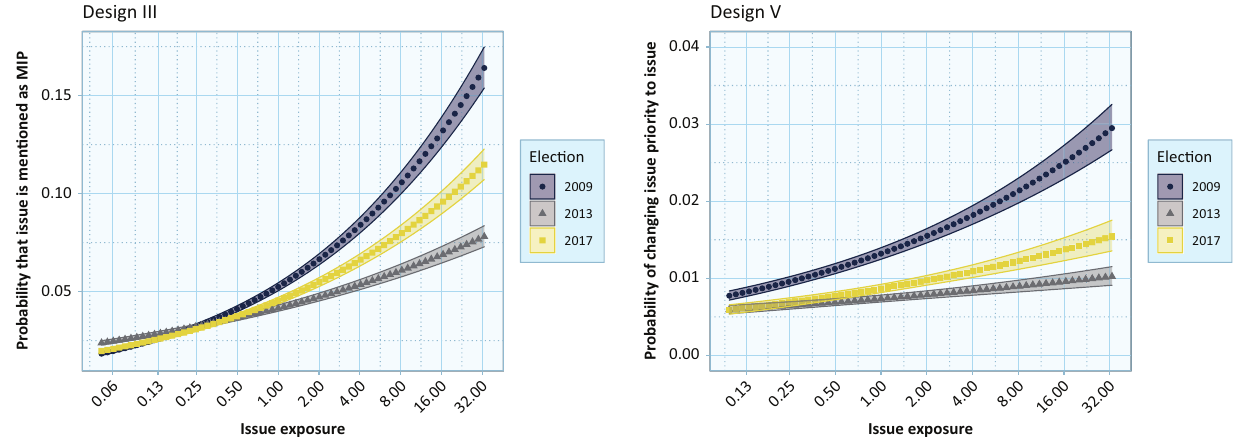
Figure 5. How agenda‐setting effects differ between elections (Designs III and